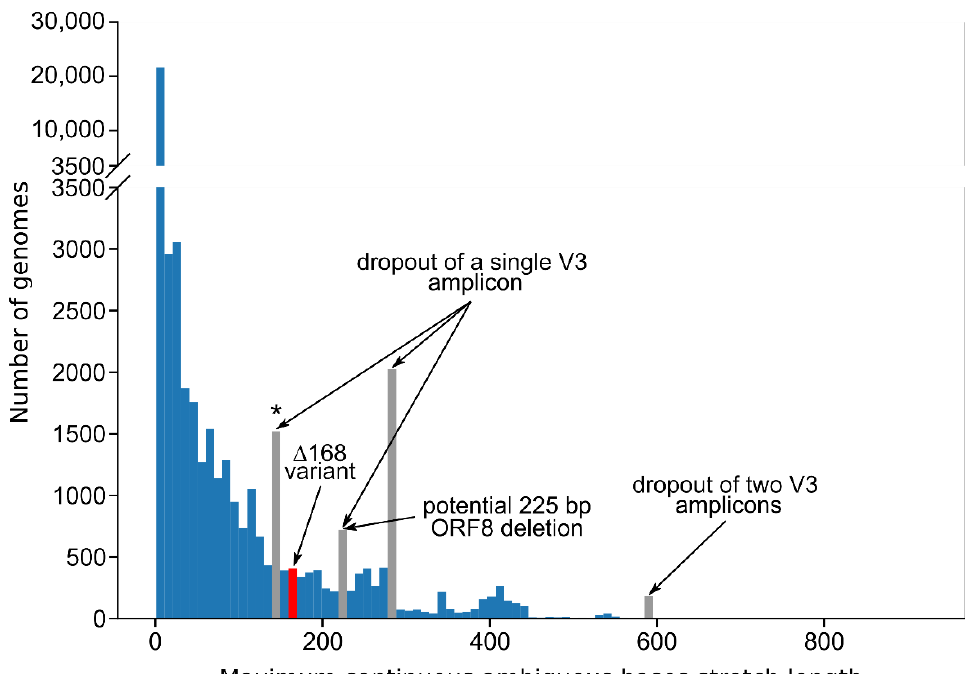
Figure 5. Histogram of the lengths of stretches of ambiguous bases and gaps in the ORF8 gene region in SARS-CoV-2 sequences from GISAID. Positions 27,577 to 28,577 were extracted from a MAFFT alignment [31] of 830,039 sequences downloaded from GISAID on 3 March 2021. The bin size was fixed at 10 bp. For each sequence the length of the longest continuous ambiguous base stretch or gap was determined. Only stretches starting and ending within the selected alignment region were counted. Stretches that are most probably attributable to certain amplicons from the ARTIC-V3 scheme that are completely missing are colored grey. The bin around 220–230 bp possibly contains a novel 225 bases long ORF8 deletion variant (28,003 to 28,227) in addition to stretches of ambiguous bases corresponding to the dropout of a single amplicon. ARTIC-V3 Amplicons 92 and 93 are fully encompassed by the selected alignment region while Amplicons 91 and 94 are only partly included. The grey bin marked with an asterisk (140 to 150 bp) corresponds to the dropout of Amplicon 91. The bin containing the ∆168 variant is colored red.